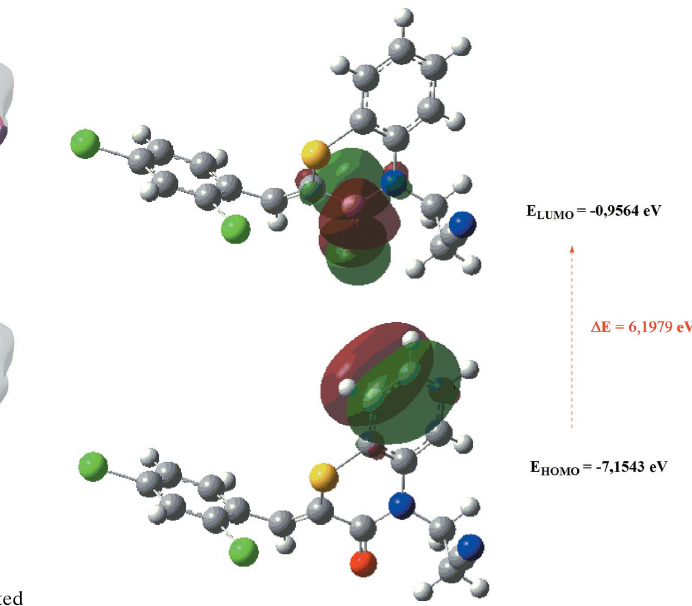
Figure 9 The energy band gap of the title compound.